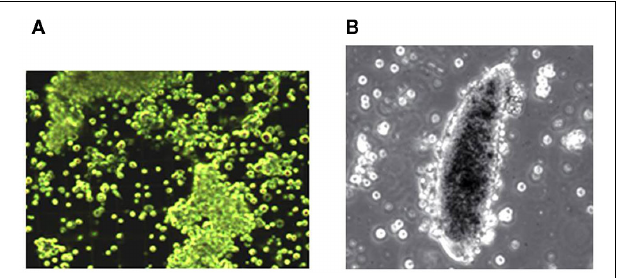
FIGURE 3 | (A) Microaggregation reactions to bacterial infection in larvae of the diamondback moth, Plutella xylostella . (B) Encapsulation in response to parasitoid egg (200 × ).The cells in these photographs range from 10–12 μ m. Nodulation is a form of encapsulation in which hemocytes surround a mature nodule rather than a parasitoid